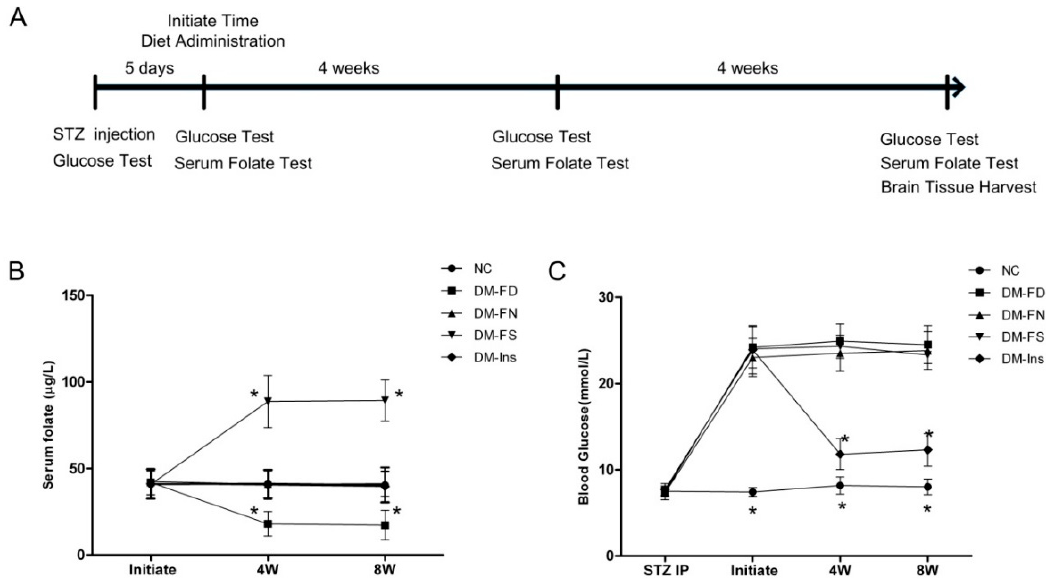
Figure 1. Experimental timeline and results of serum folate and blood glucose level. Timeline depicting serum folate as well as blood glucose testing at baseline and every 4 weeks throughout the study ( A ); STZ-treated mice were divided into four groups: folate-deficient diet plus daily gavage with water (DM-FD); control diet plus daily gavage with water (DM-FN); control diet plus daily gavage with 120 µ g/kg folic acid (DM-FS) and control diet plus daily gavage with water and insulin treatment (DM-Ins). Additionally, mice fed with the control diet and gavaged daily with water as normal control group (NC). Serum folate in STZ-treated mice was determined by an automated chemiluminescence system ( B ); Blood glucose in tail vein was tested by glucometer ( C ). Plotted are mean ± SD values, n = 11 animals/group. * p < 0.05 versus the DM-FN group. STZ, streptozotocin.